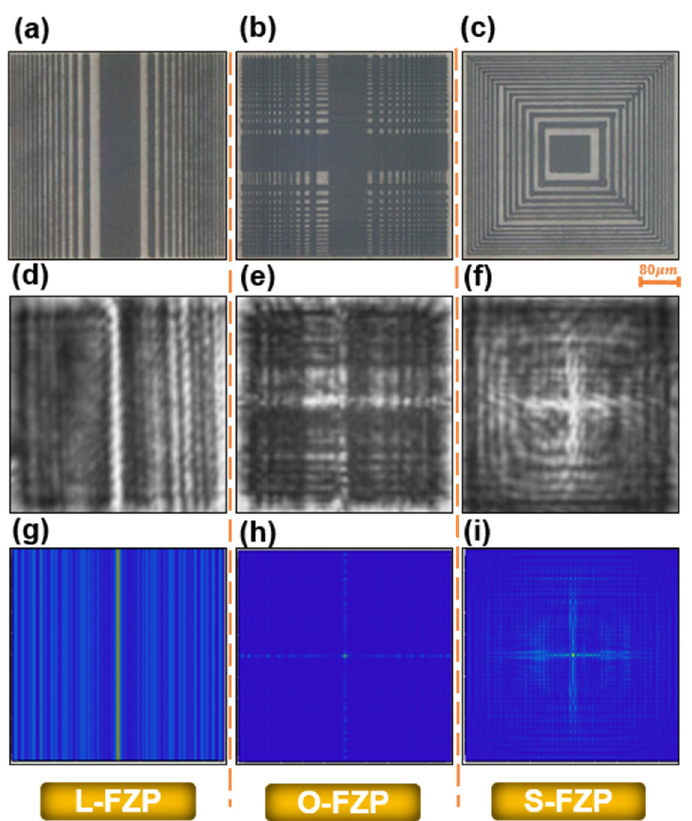
Figure 9. The fabricated morphology of ( a ) L-FZPs ( b ) O-FZPs ( c ) S-FZPs; the diffractive perfor- mance of corresponding FZPs: ( d – f ): experimental patterns; ( g – i ): simulation patterns. of corresponding FZPs: ( d – f ): experimental patterns; ( g – i ): simulation